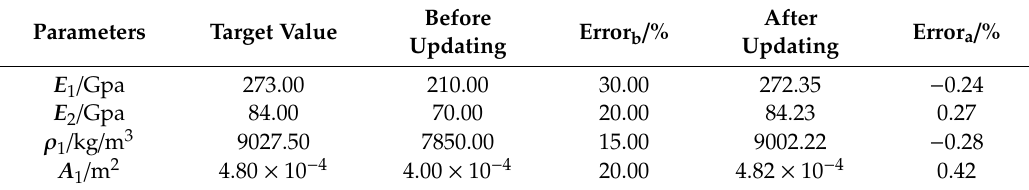
Table 6. Comparison of Parameters Before and After Model Updating Under 5% White noise.